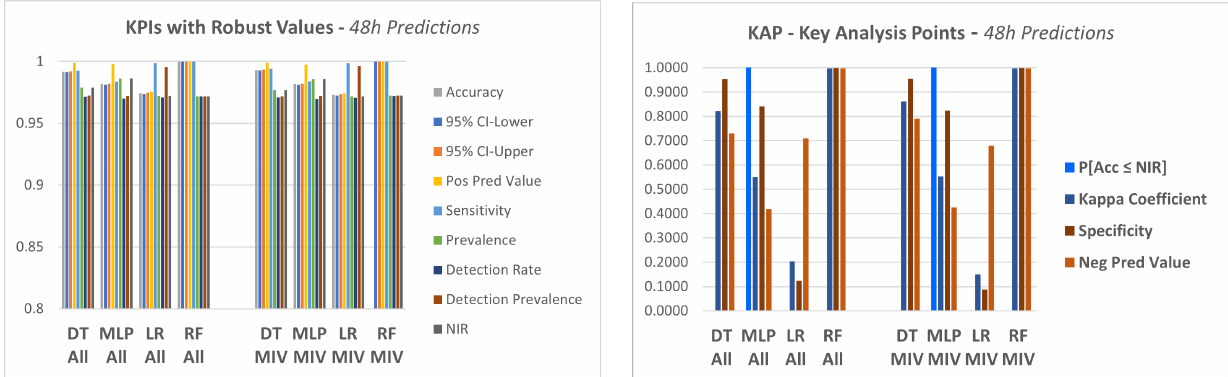
Figure 11. Methods Comparison by KPIs for Alarm Prediction in 24 h.